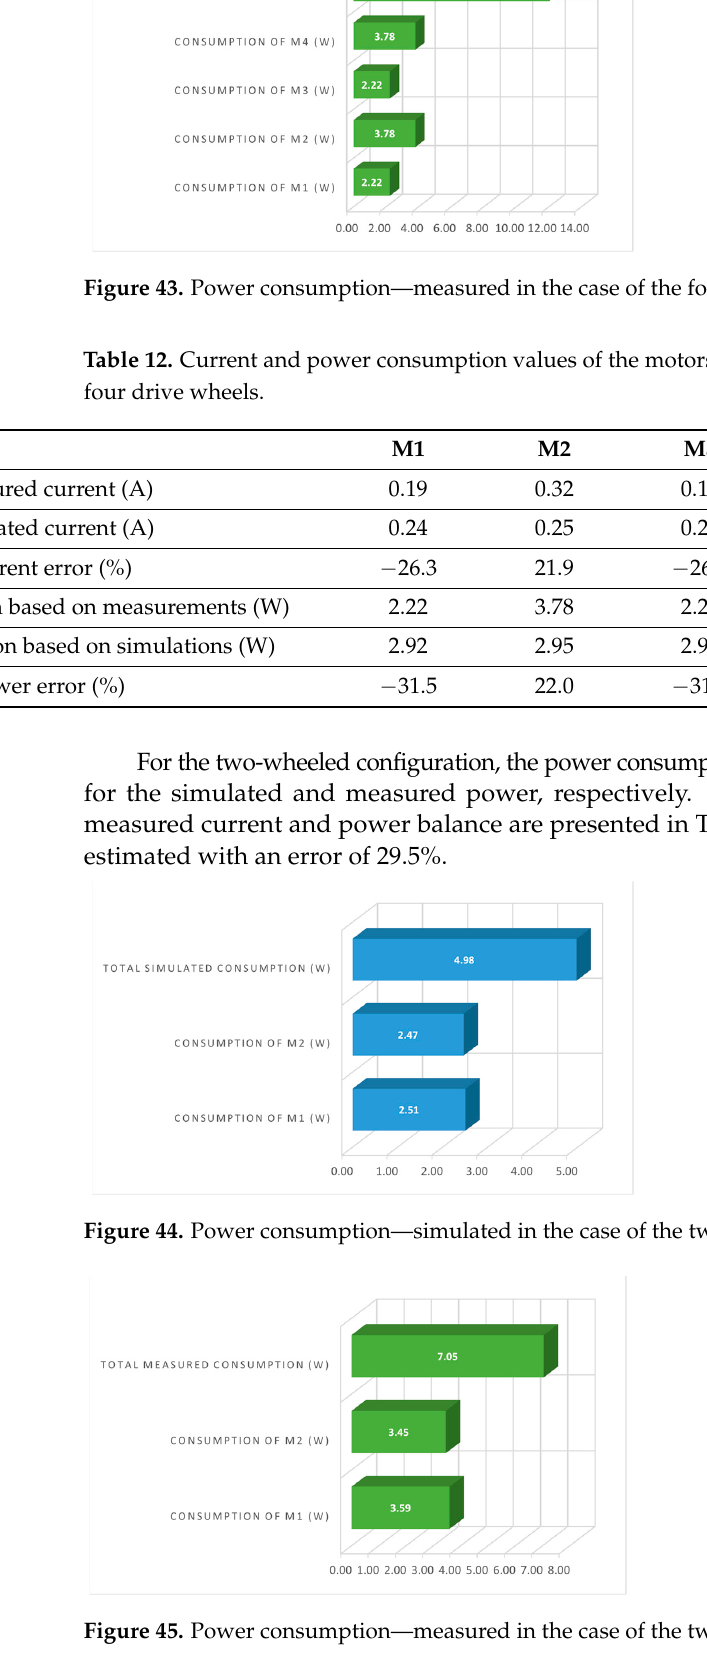
Figure 42. Power consumption—simulated in the case of the four-wheeled robot.